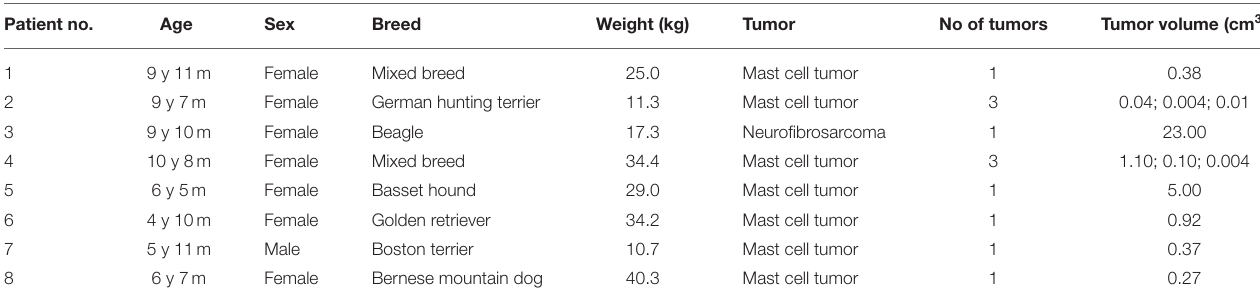
TABLE 1 | Characteristics of the eight dogs treated with electrochemotherapy (ECT) combined with gene electrotransfer of plasmid DNA encoding canine interleukin-12 (GET pIL-12). Patient no.